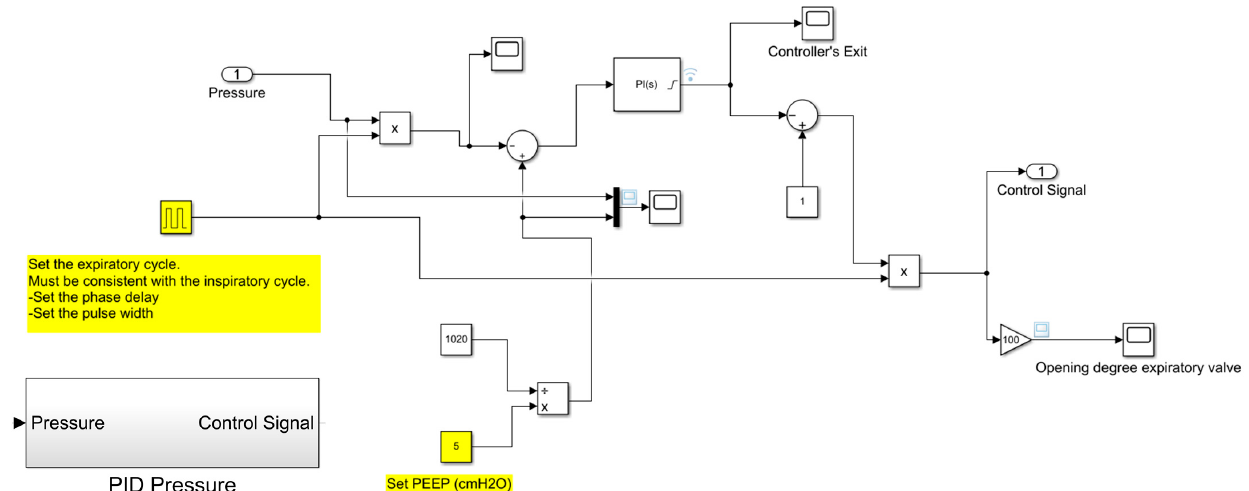
Figure 17. Subroutine reproducing the automatic control of the positive end ‐ expiratory pressure.